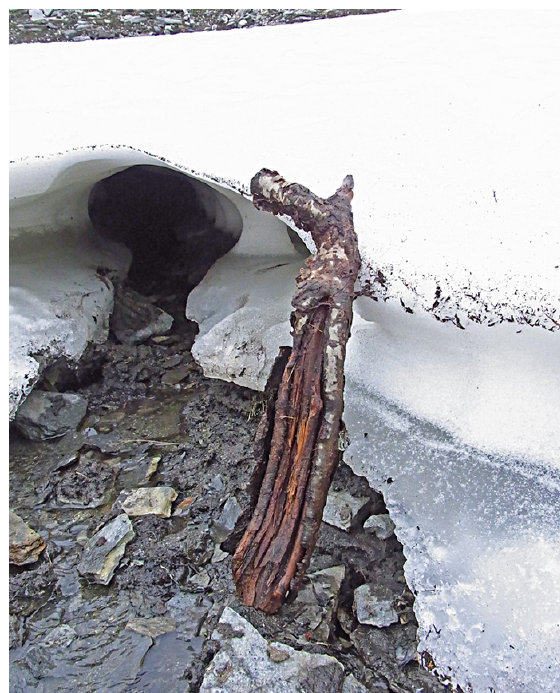
Figure 39: Slåttatjåkka (9). Birch stem recently exposed by the main outwash stream of the ice patch (1025 ma s.l.). 530 cal. yr BP (Beta- 284457).